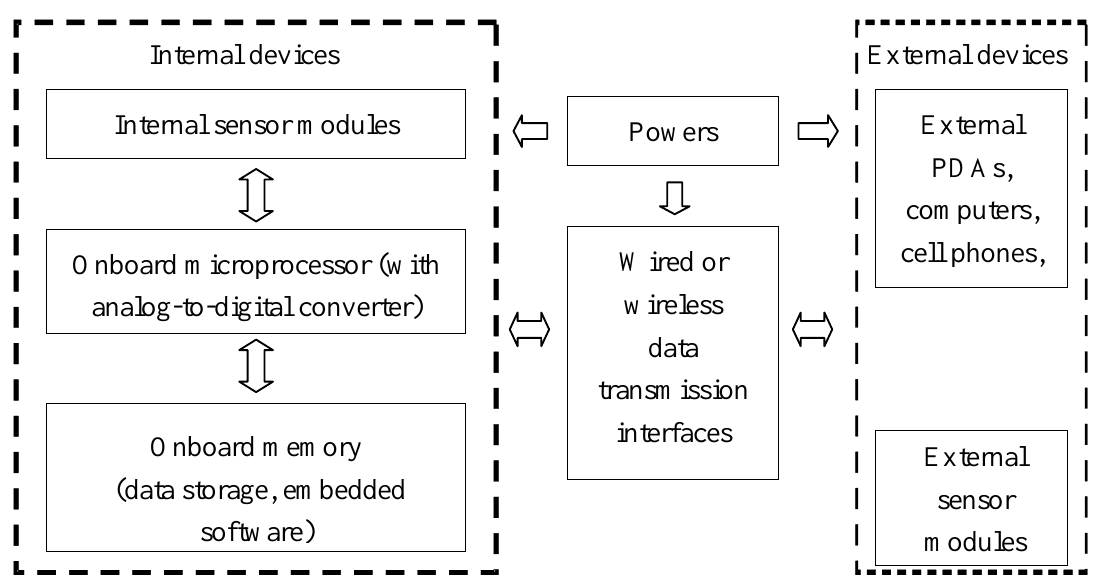
Figure 2. Integrated sensor system for PHM